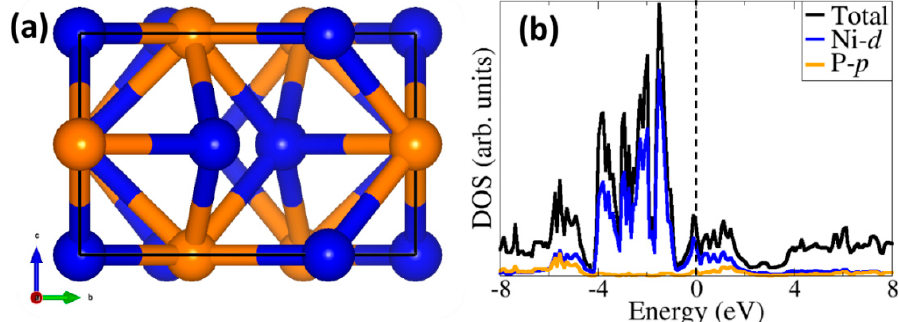
Figure 1. ( a ) Hexagonal structure of bulk Ni 2 P and ( b ) projected density of states (PDOS) showing the metallic character of Ni 2 P. Colour code: Ni = blue, P = orange.